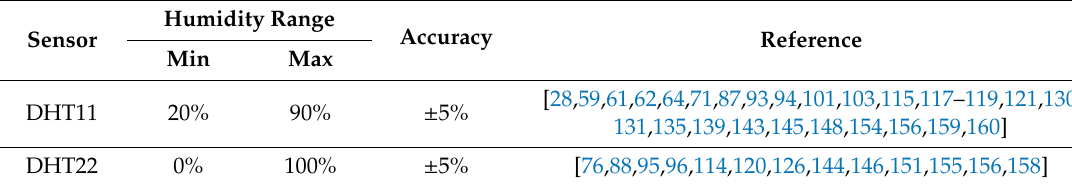
Table 3. Relative humidity monitoring sensors.